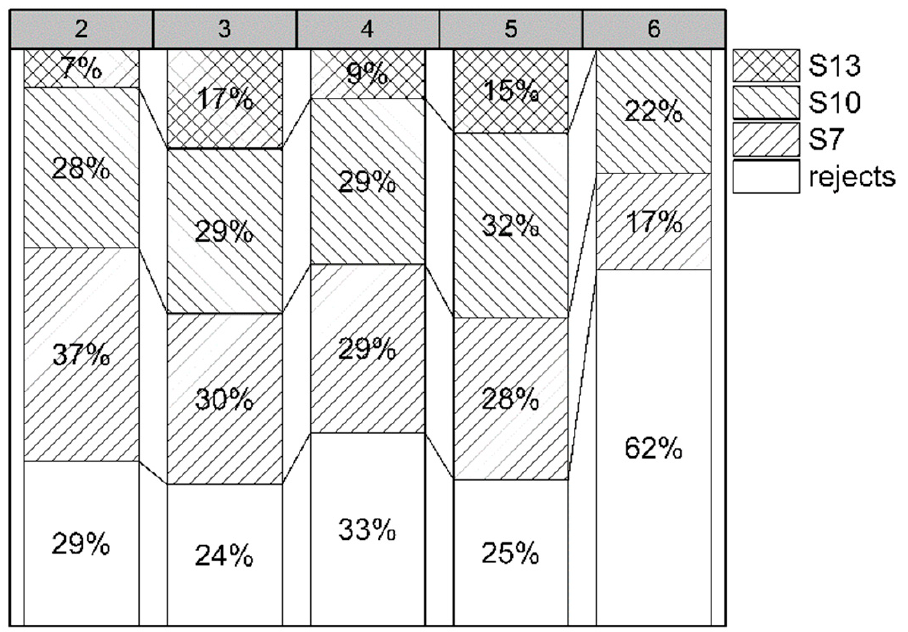
Figure 6. Distribution of the quality grading classes of spruce lamellae of plots 2 to 6. Visually sorted according to DIN 4074-1 [15].